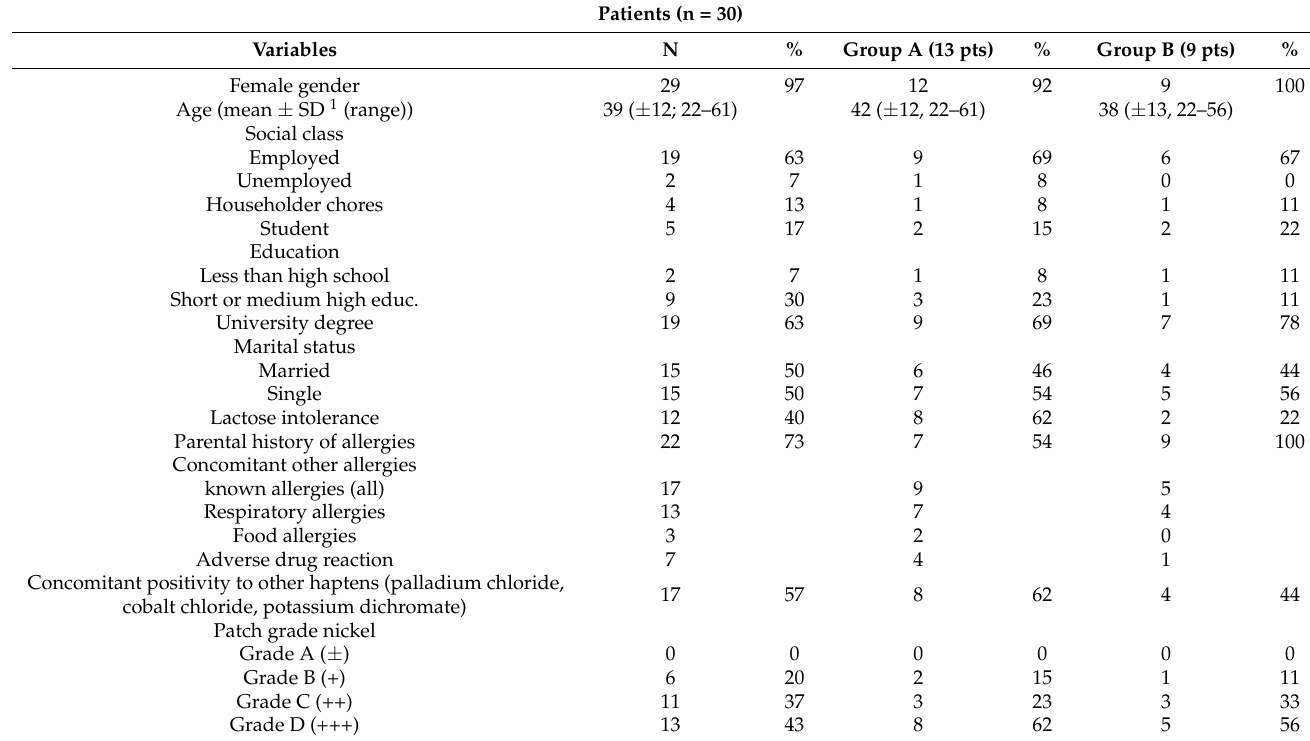
Table 1. The baseline socio-demographics and clinical characteristics of the